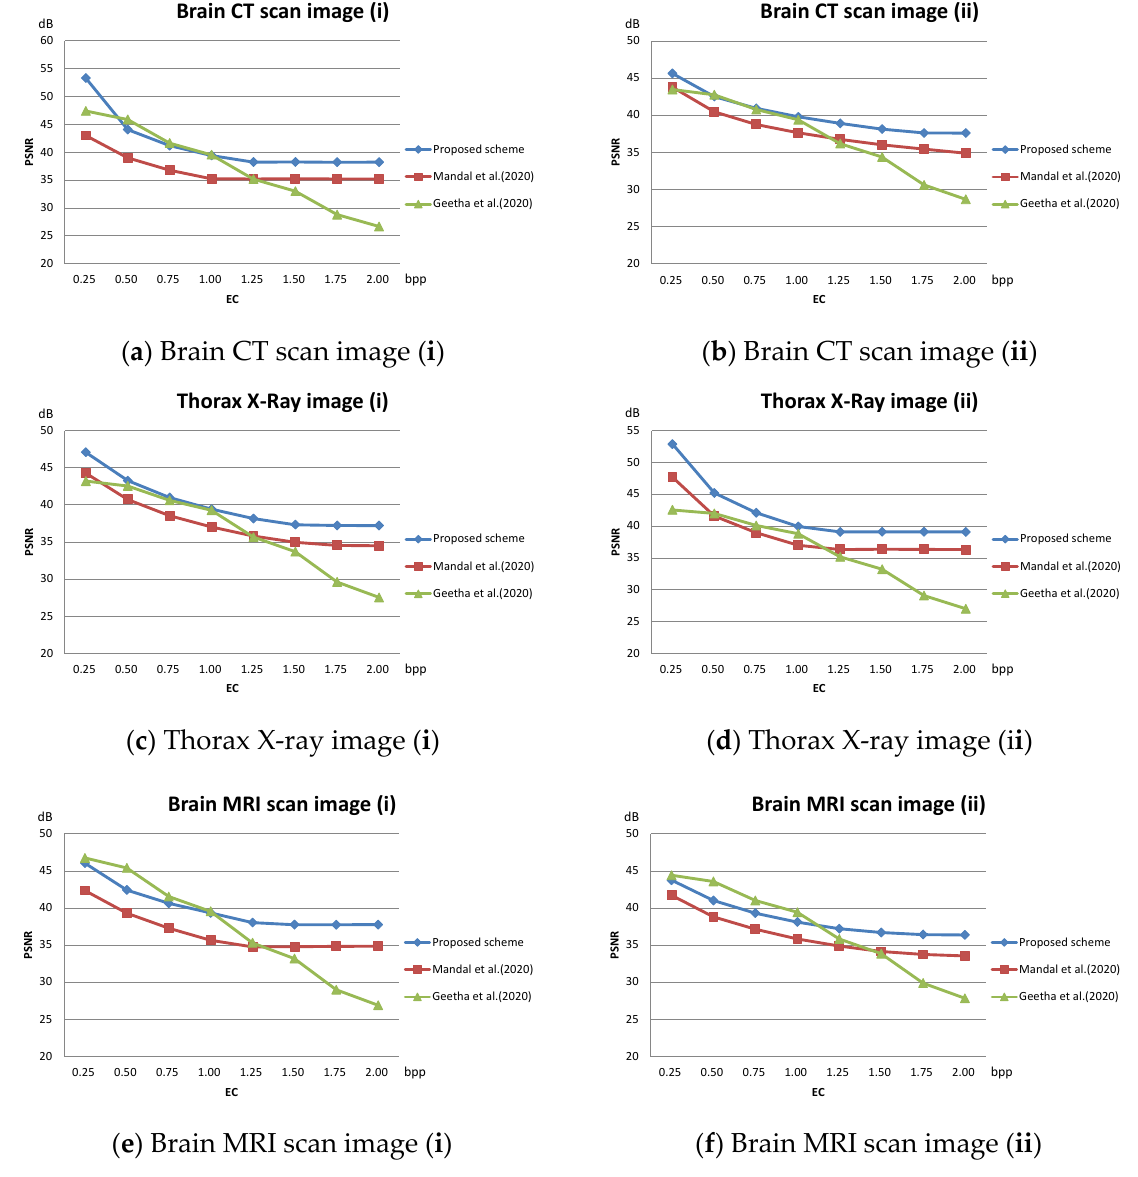
Figure 12. Comparison of PSNR on medical images; ( a ) Brain CT scan image ( i ); ( b ) Brain CT scan image ( ii ); ( c ) Thorax X-ray image ( i ); ( d ) Thorax X-ray image ( ii ); ( e ) Brain MRI scan image ( i ); ( f ) Brain MRI scan image ( ii ). The method published by Mandal et al. [20] treats all pixel blocks the same. When executing DE embedding in its second data hiding phase, the large pixel value differences cause the pixel values to be drastically modified, which significantly reduces the PSNR value of the stego image. In our scheme, the pixel blocks are classified into smooth and complex ones in advance. During data hiding, DE embedding of complex blocks is omitted, which effectively improves the PSNR value. For the smooth blocks, the block mean interpolation ensures a controllable difference value between interpolated pixels